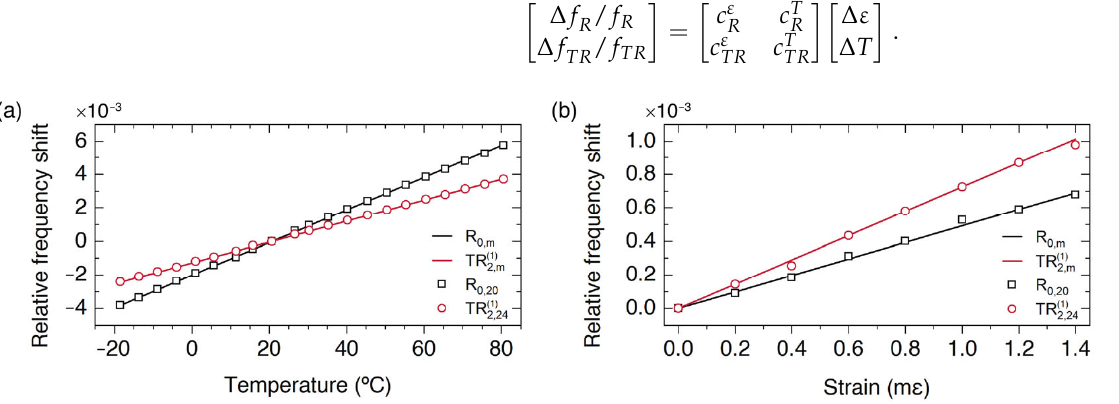
(cid:2870)(cid:2872)(cid:4666)(cid:2869)(cid:4667) versus temperature ( a ) and strain ( 1 ) versus temperature ( a ) and strain ( b ). (cid:2870) , 2,24 (cid:3040)(cid:4666)(cid:2869)(cid:4667) , of ( 1 ) , of each series (cid:2870) , 2, m